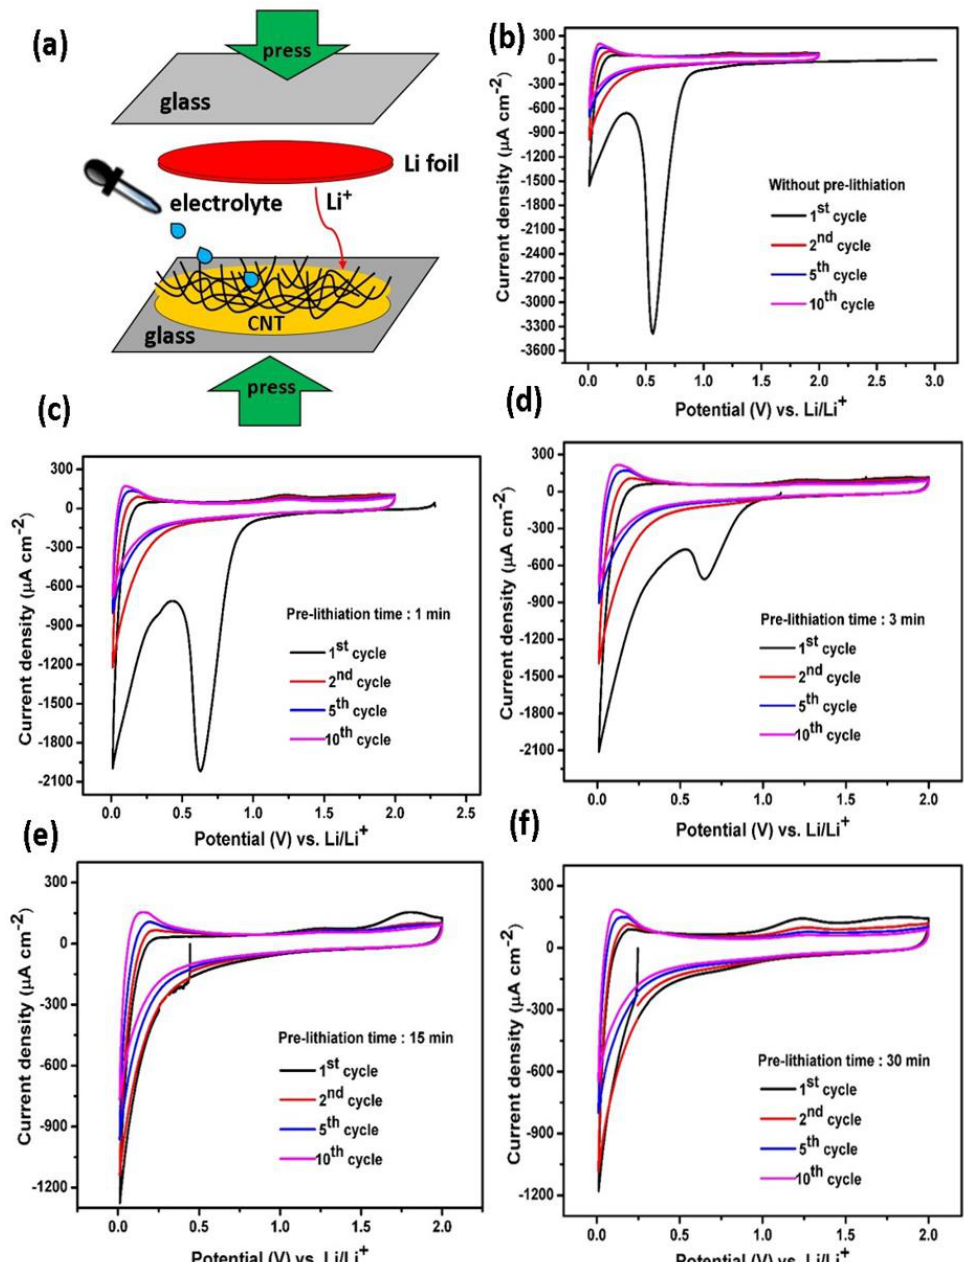
Figure 3. A schematic representation of a direct pre-lithiation method ( a ), cyclic voltammogram curves of the pristine CNT ( b ), pre-lithiated CNT for 1 min ( c ), pre-lithiated CNT for 3 min ( d ), pre-lithiated CNT for 15 min ( e ) and pre-lithiated CNT for 30 min ( f ) recorded at a scan rate of 0.2 mV s −1 in a potential range of 0.01–2 V vs . Li/Li + .